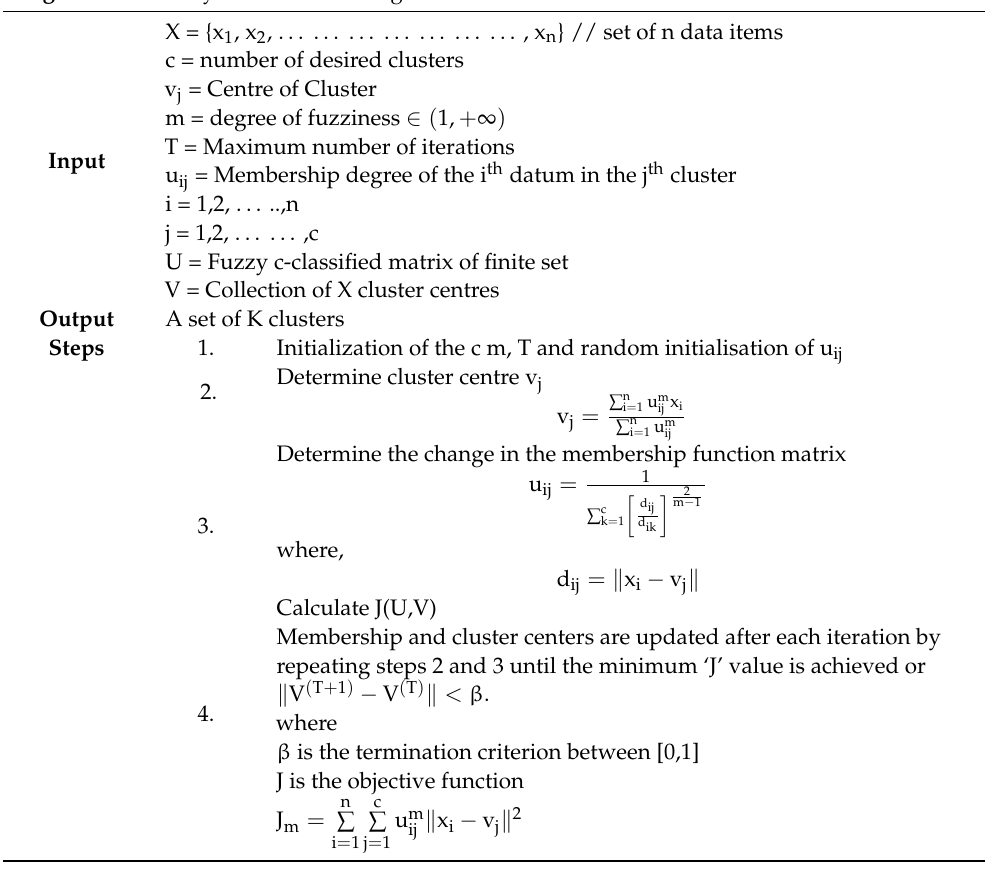
Algorithm 2: Fuzzy C-mean clustering